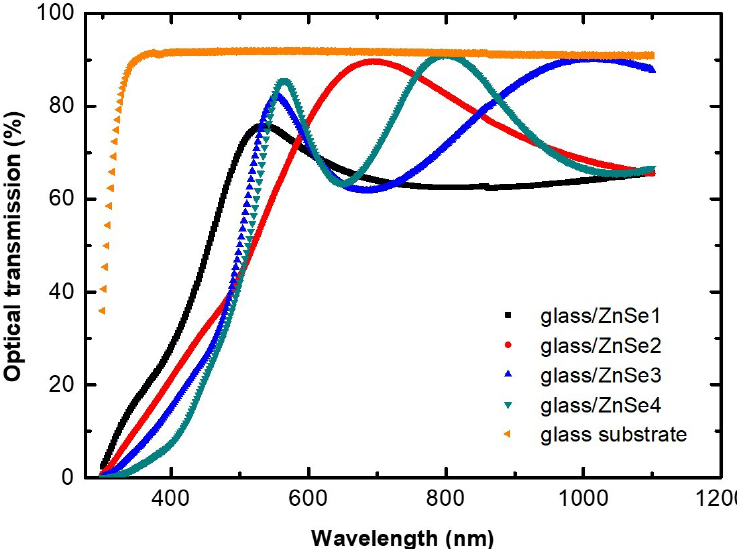
Figure 6. Optical transmission spectra of ZnSe thin films deposited onto optical glass substrates at different RF power. The reference spectrum of the optical glass substrate is depicted in